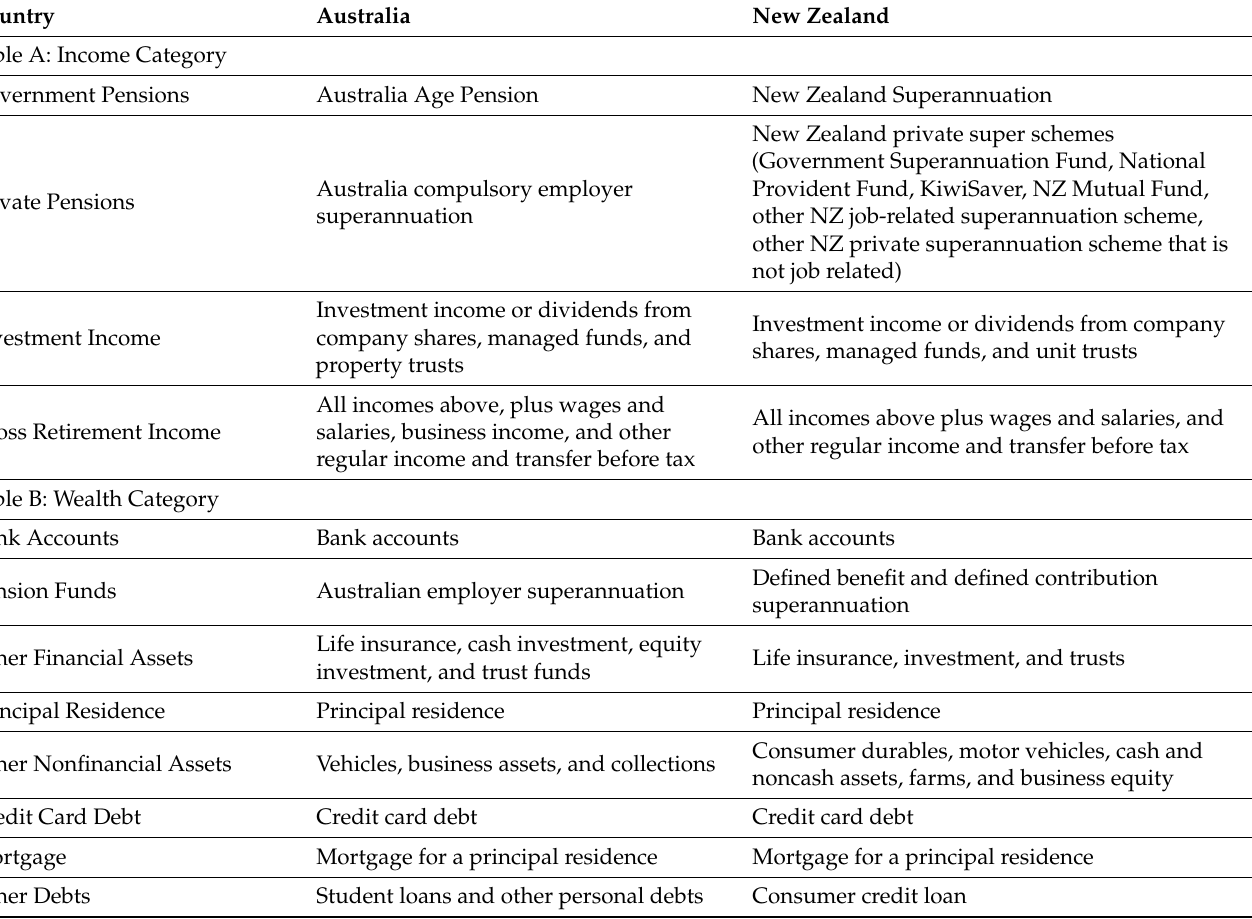
Table 1. Australia HILDA and New Zealand HES income and wealth categories from survey data. Country Table A: Income Category